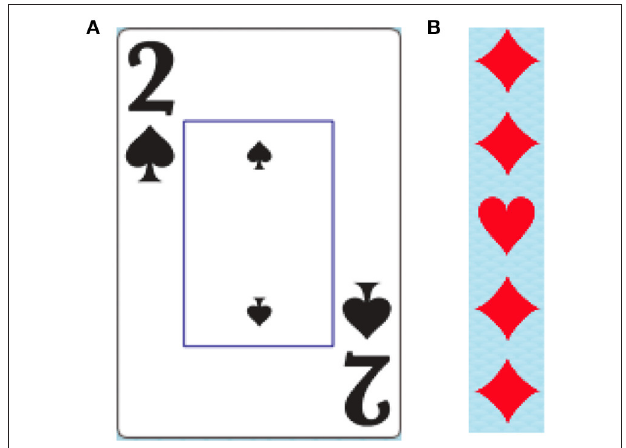
FIGURE 1 | Example of card suit stimuli used in the DalCAB tasks. (A) Card as shown in simple response, inhibition, decision speed, dual task and item working memory tasks. (B) Card suit shapes as shown in the flanker tasks. Card suit shapes like those in (B) are also used in the visual search task.